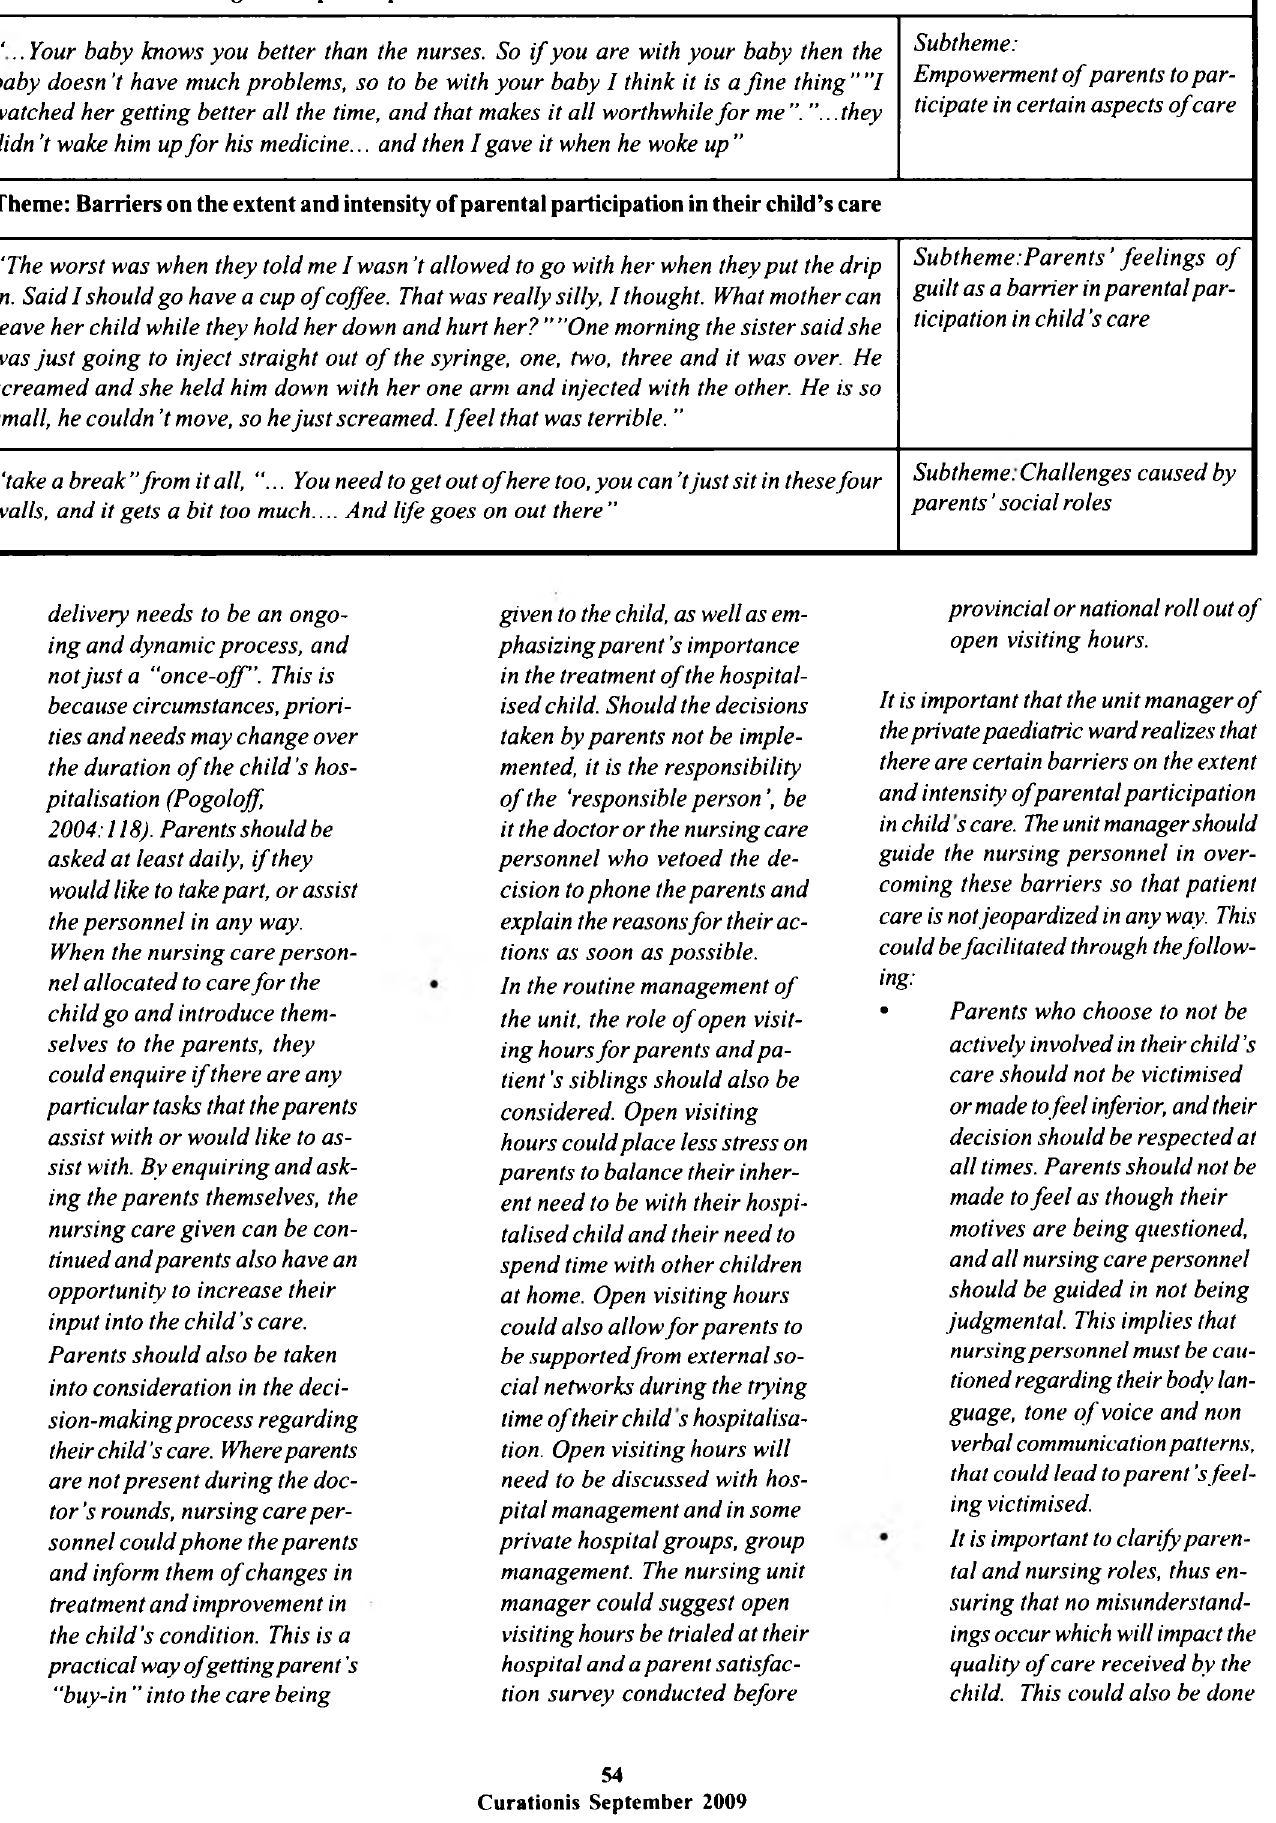
Table 2: Examples of raw data that were interpreted as experiences relating to Category 1: Experiences related to the interactive processes in the paediatric unit Subcategory 1.1: Parental